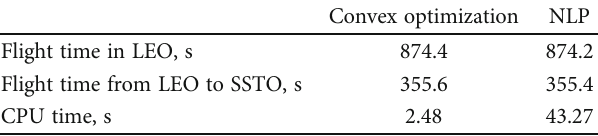
Table 4: Comparison of simulation results.